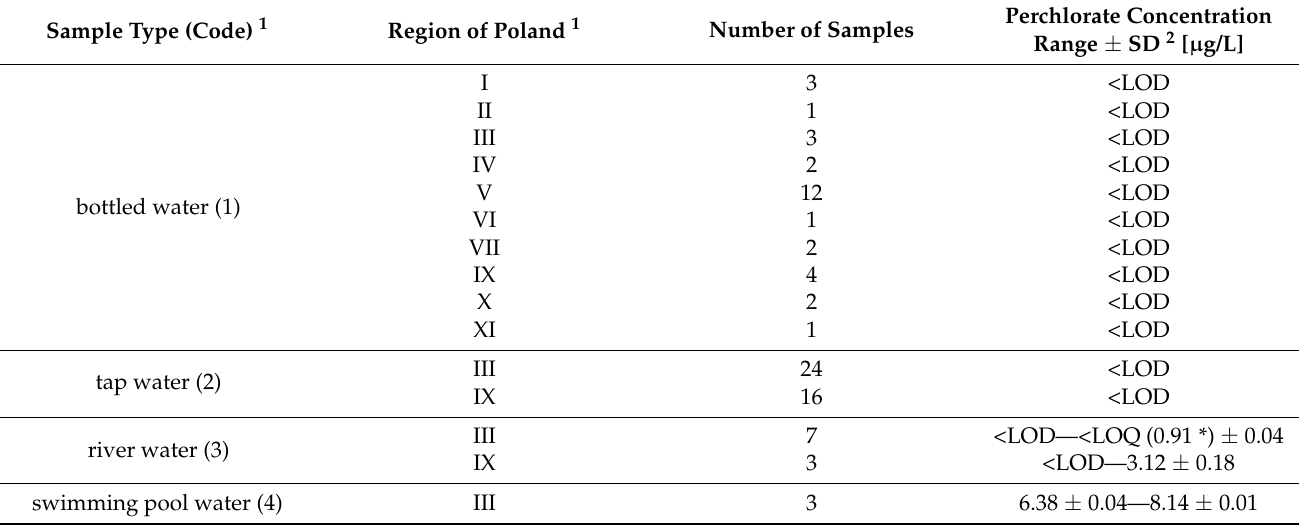
Table 1. Results of perchlorate determination in water